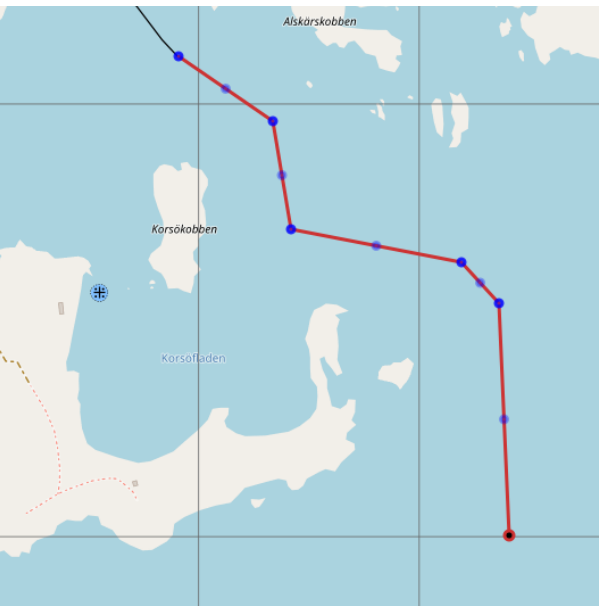
Figure 2. The navigational way near Korsakobben Island (Stockholm archipelago) with bends in the channel [21].